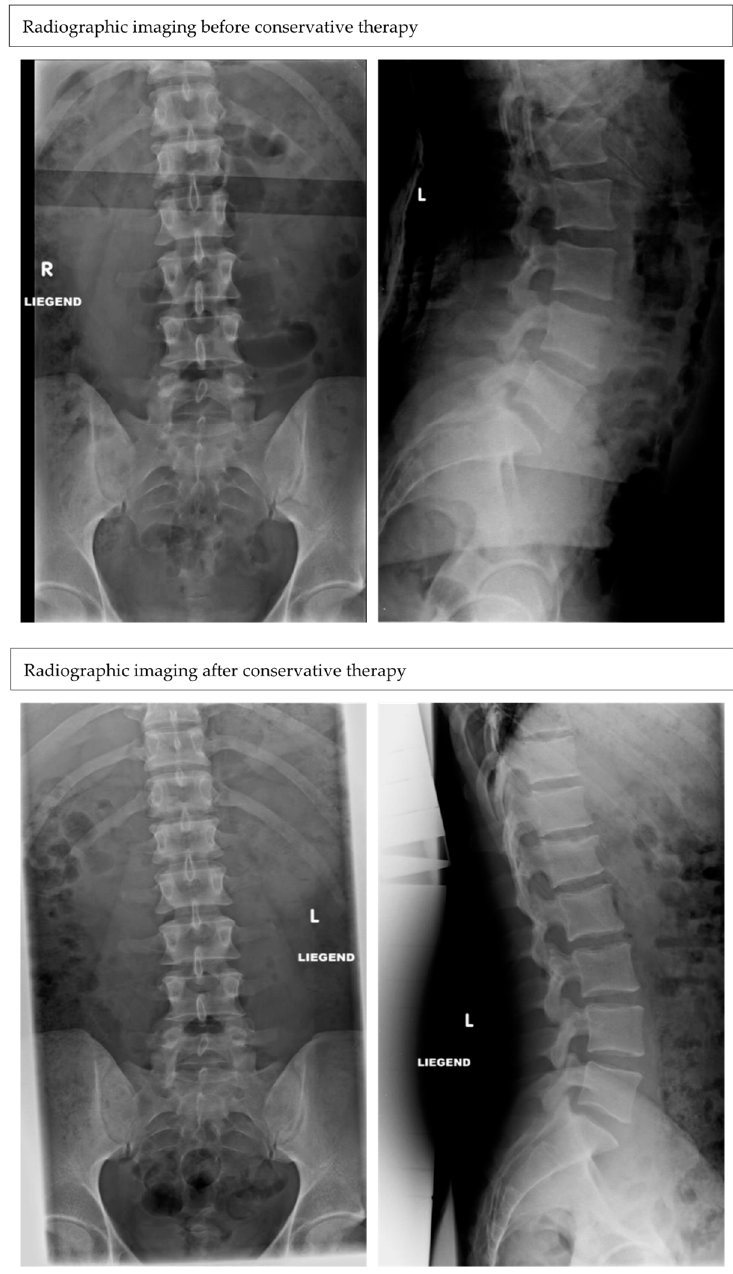
Figure 2. Radiographs (anterior–posterior and lateral) of a patient, 26 years old, with an A1 fracture of L1 after a fall of 2 m, before and after conservative treatment with a brace for 12 weeks in total. No dynamic and further sintering were detected after the last follow-up.